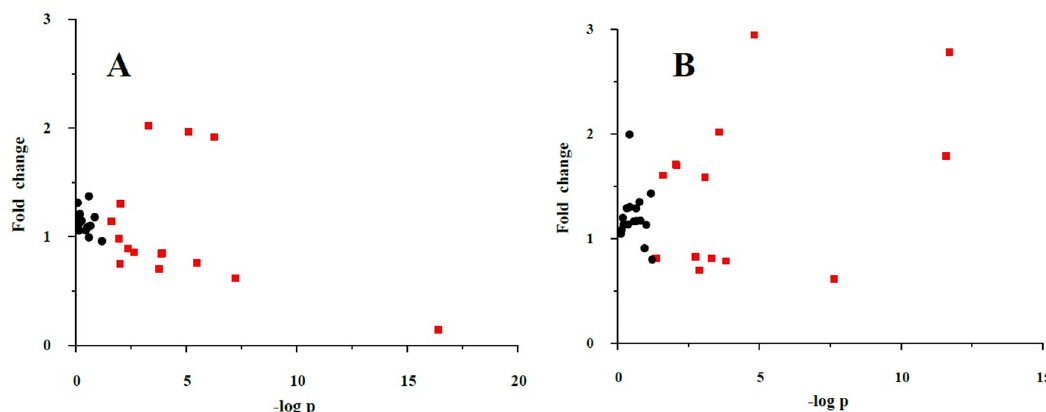
Figure 2. Fold change and significance of metabolite change during an oral glucose challenge in the control ( A ) and the HLP ( B ) groups. Dots represent the 32 metabolites detected in serum. Change is with respect to the fasting metabolite levels. Significant ( p < 0.05) changes are colored red. Fold changes and percent changes for the metabolites (X) detected by UPLC-TQ-MS were calculated as follows: X Fold change = (X Concentration at 120 min /X Concentration at baseline ).